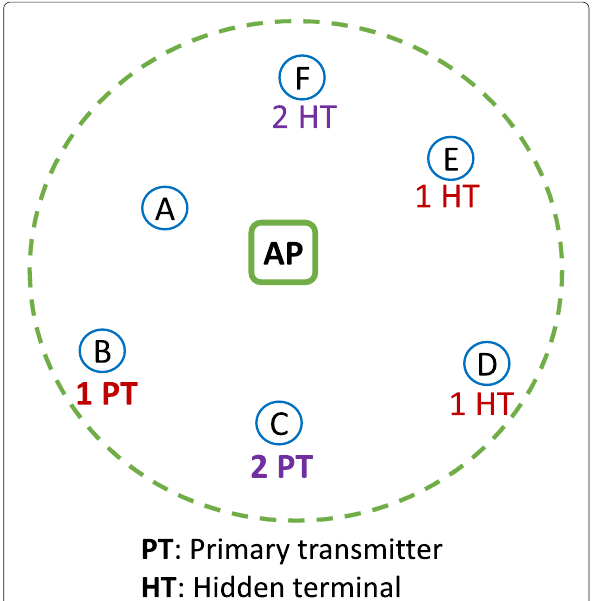
Fig. 11 Typical topology of a WLAN that consists of hidden